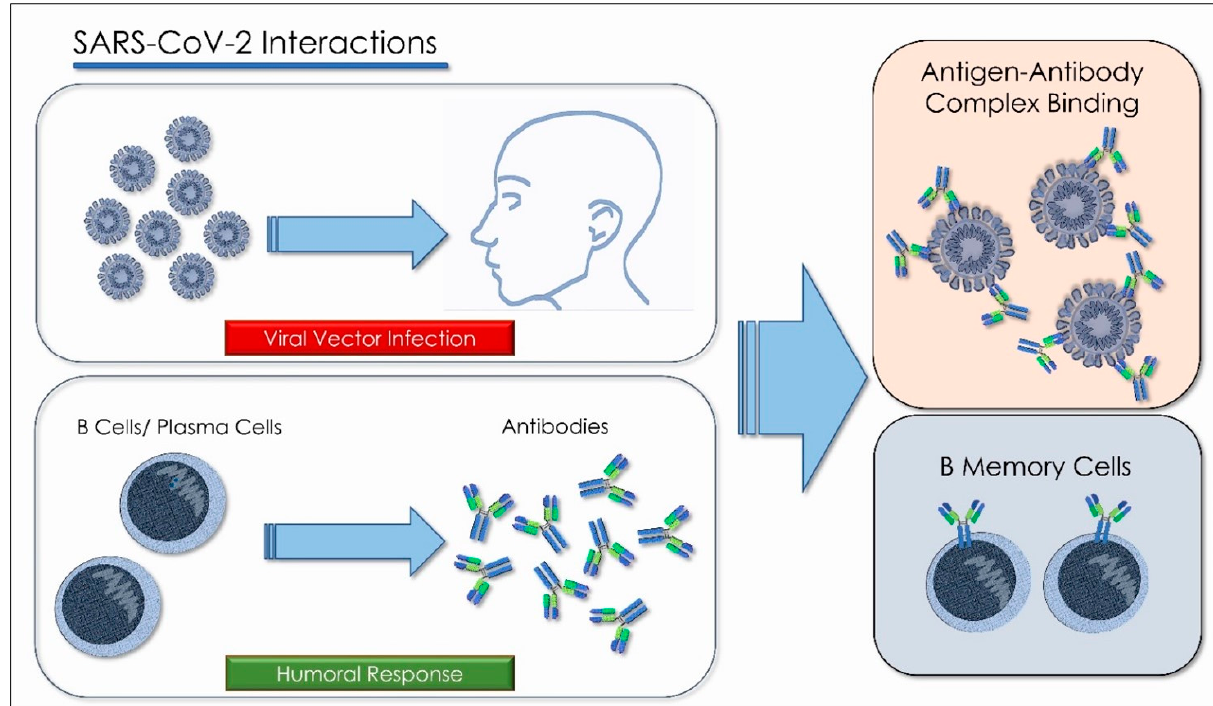
Figure 4. Humoral response of the antigen and human cellular immunity against SARS-CoV-2 infection.